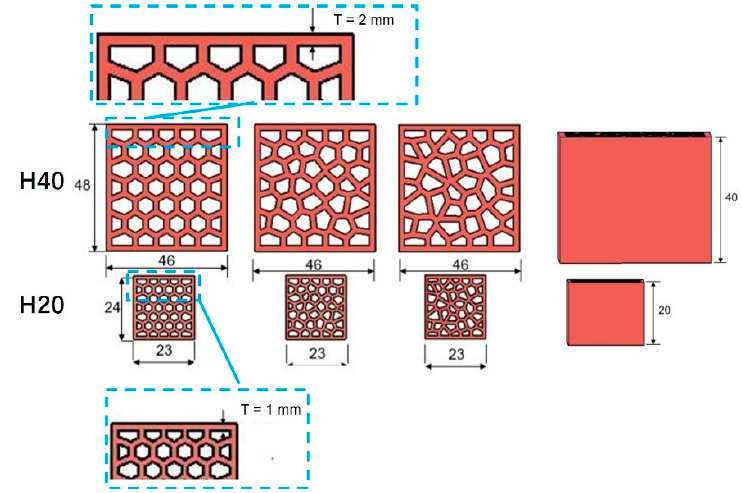
Figure 6. Specimen dimensions and various designs, indicated in [mm].